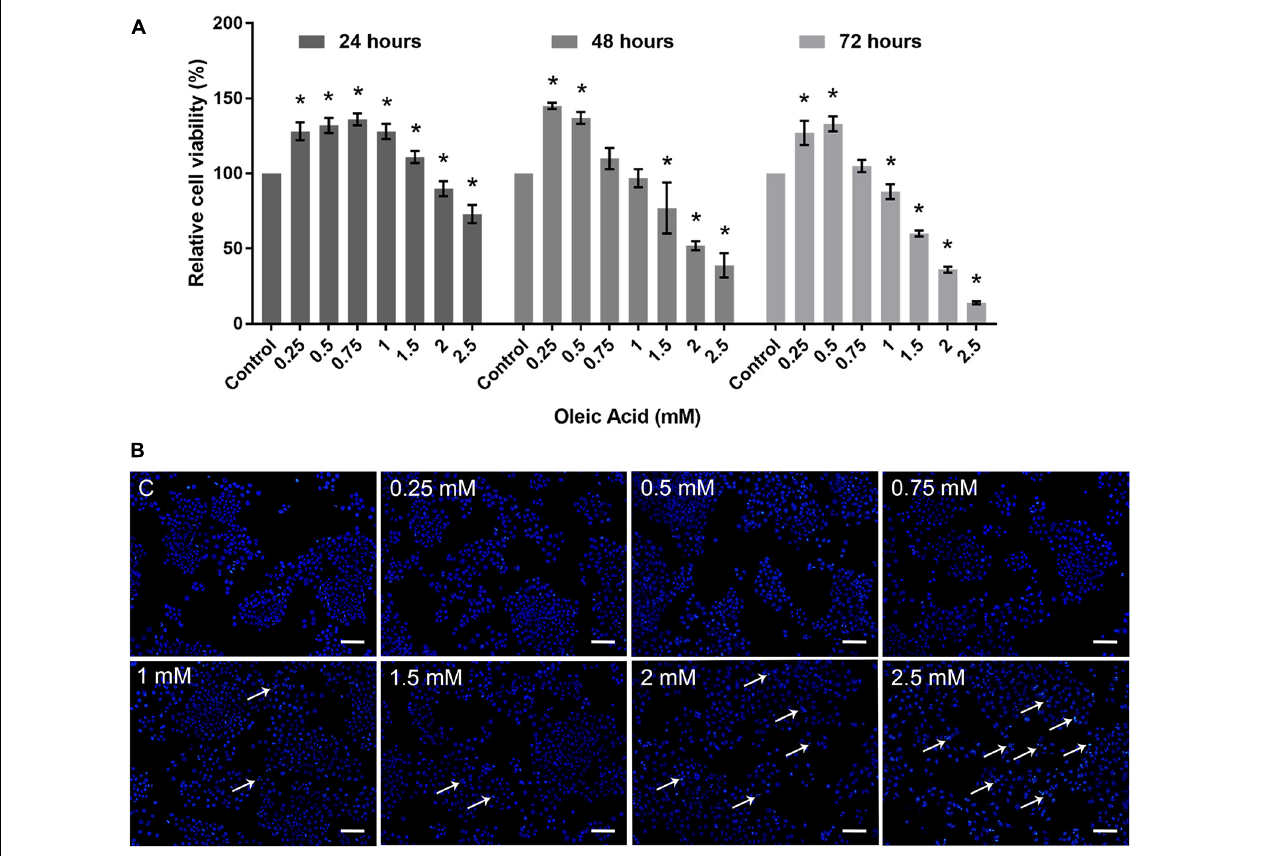
FIGURE 2 | Toxicity of OA on HepG2 cells. (A) Proliferation ratio of HepG2 cells treated with different concentrations of OA for 24, 48, and 72 h. (B) The evaluation of apoptosis for 24 h. Hoechst 33342 was used to stain the nuclei. Apoptotic cells were indicated by white arrowheads. Images taken at 10 × magnification. Scale bars: 100 µ m. Experiments were performed in triplicates in three independent experiments. * p < 0.05, compared with the control